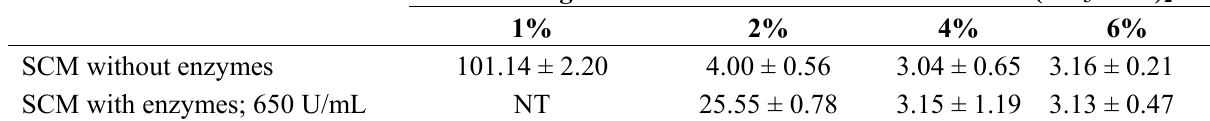
Table 2. The percentage release of MSKE from ZPG beads prepared with different COO) solution in SCM with the absence or presence of concentrations of Zn(CH 3 2 pectinolytic enzymes (650 U/mL) after incubation for 13 h at 37 °C. (Data represent the mean ± SD, n =